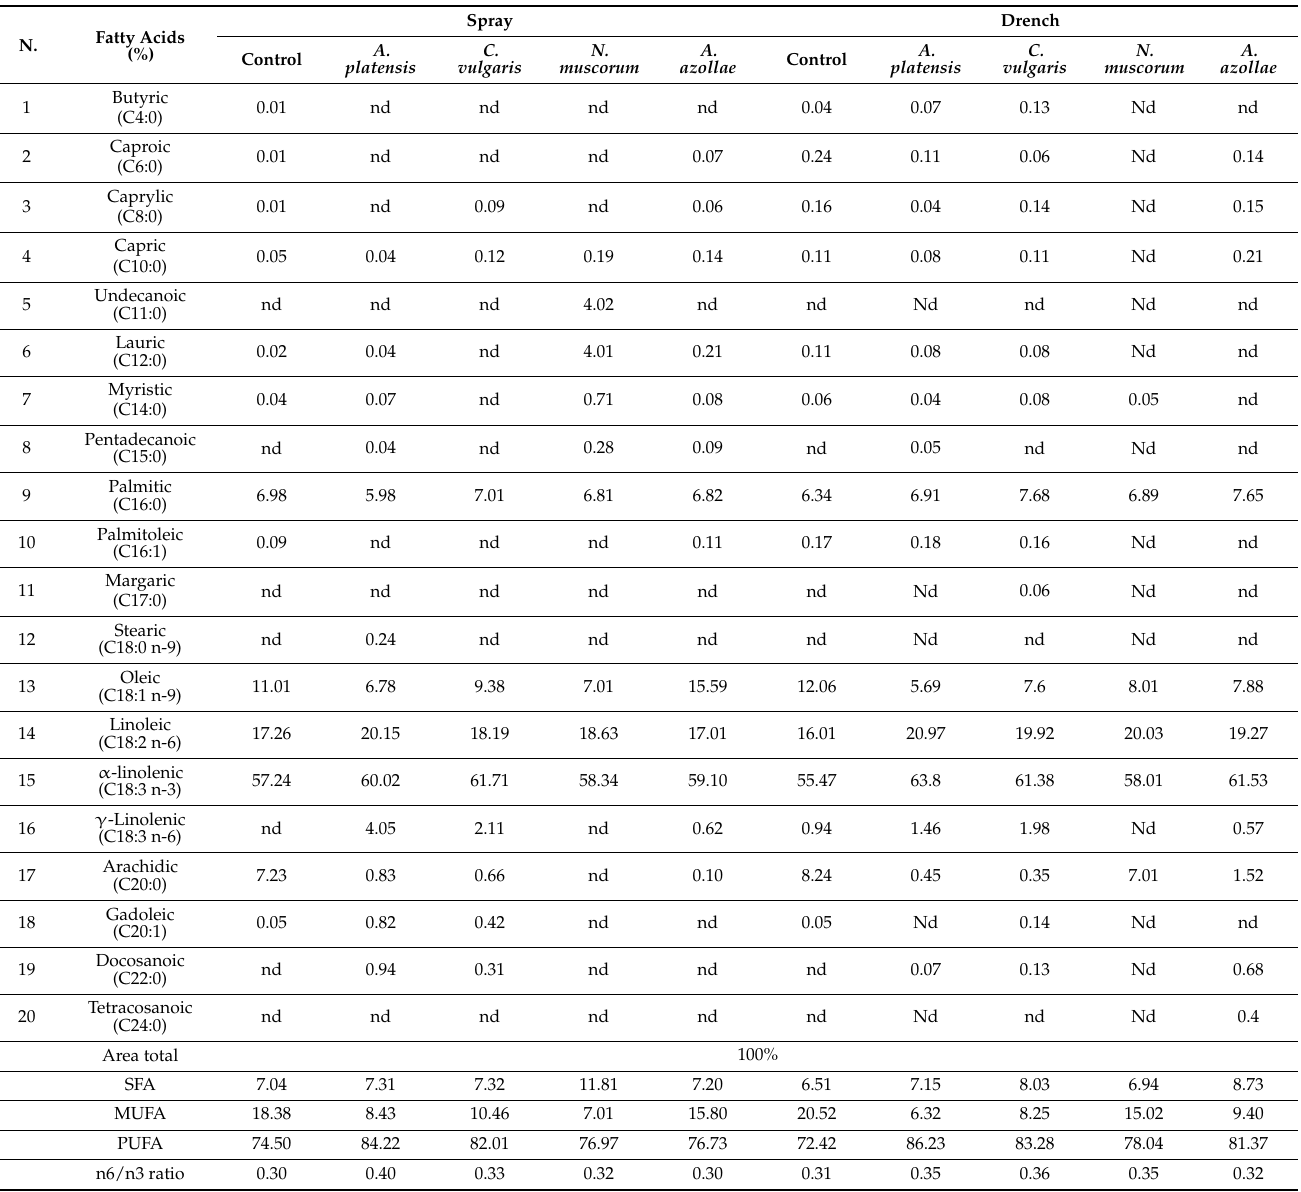
Table 4. The interactive effect of different application methods and various microalgae applications on the fatty acid profile of chia plants cultivated under alkaline